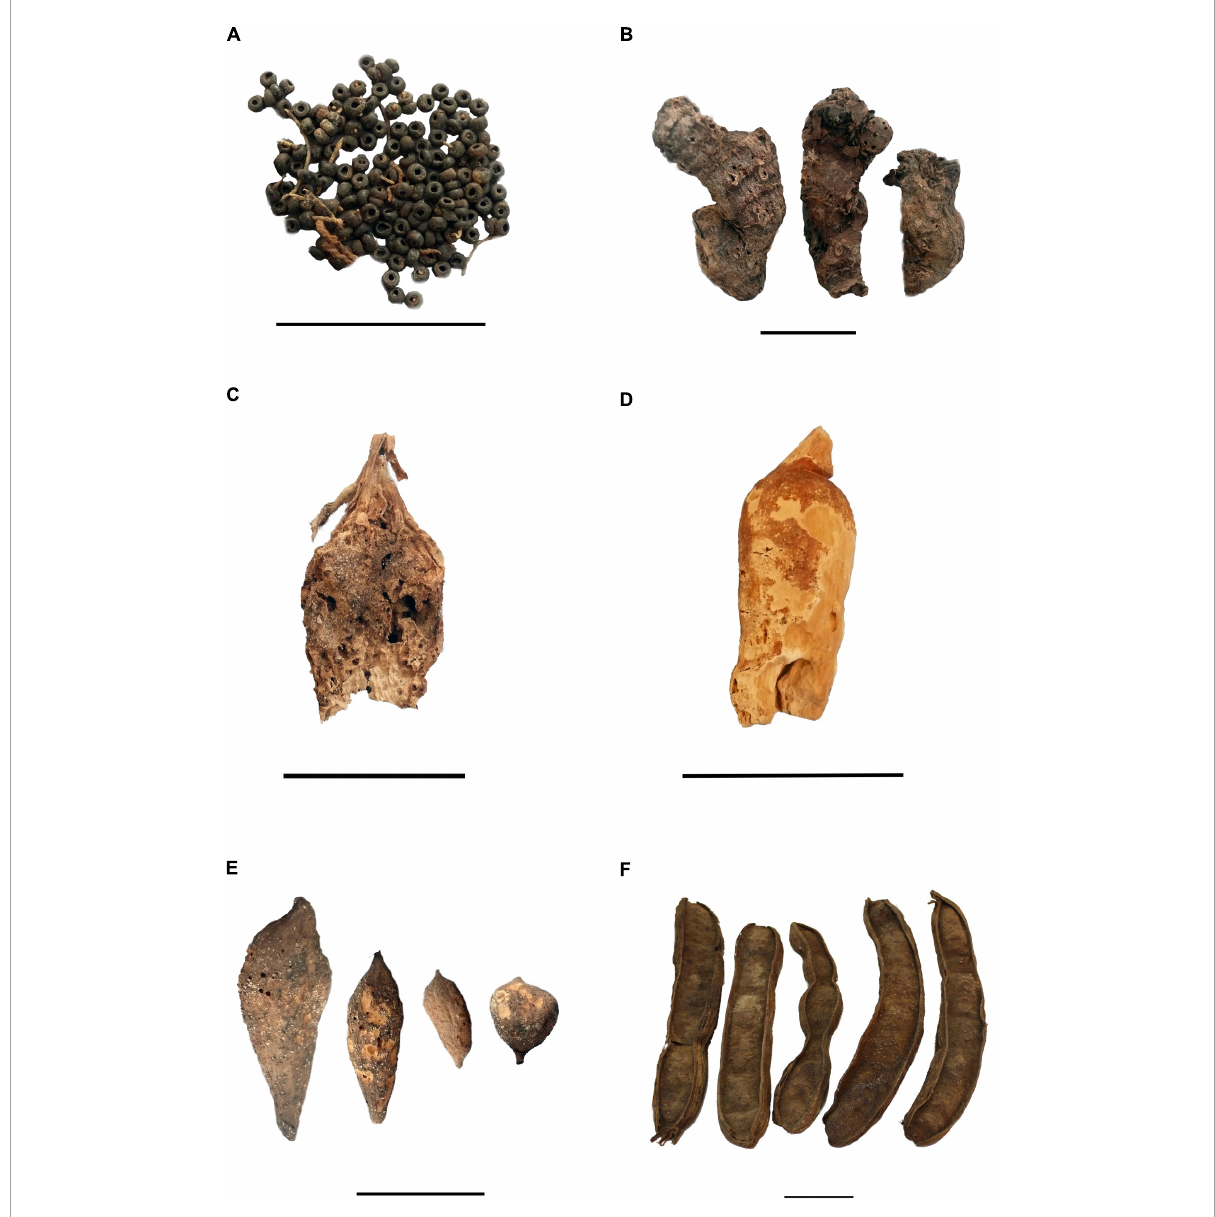
FIGURE2 Archaeobotanical remains from the Atacama Desert, northern Chile: (A) Seeds and (B) rhizomes of achira ( C. indica ) from Az-14 (sample 27691), (C) tuberous root of ahipa ( Pachyrhizus sp.) from Az-14 (sample 27690); (D) tuberous root of cassava ( M. esculenta ) from PLM-7 (sample 27501.1), (E) tuberous roots of sweet potato ( I. batatas ) from sample Az-Indet (sample 28), (F) pods of pacay ( I. feuillei ) from Az-71a (sample 5). Scale bars: 5